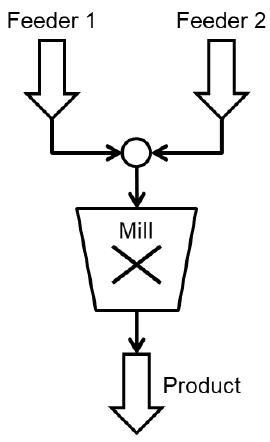
Figure 8. Flowsheet structure of the breakage process.